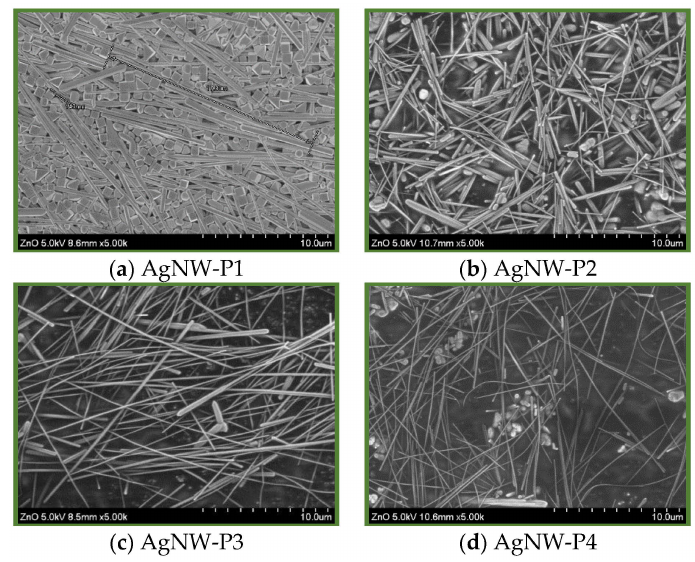
Figure 1. SEM images of AgNWs synthesized by mole ratio of Ag + ion:PVP repeat unit, ( a ) 1:1.5;